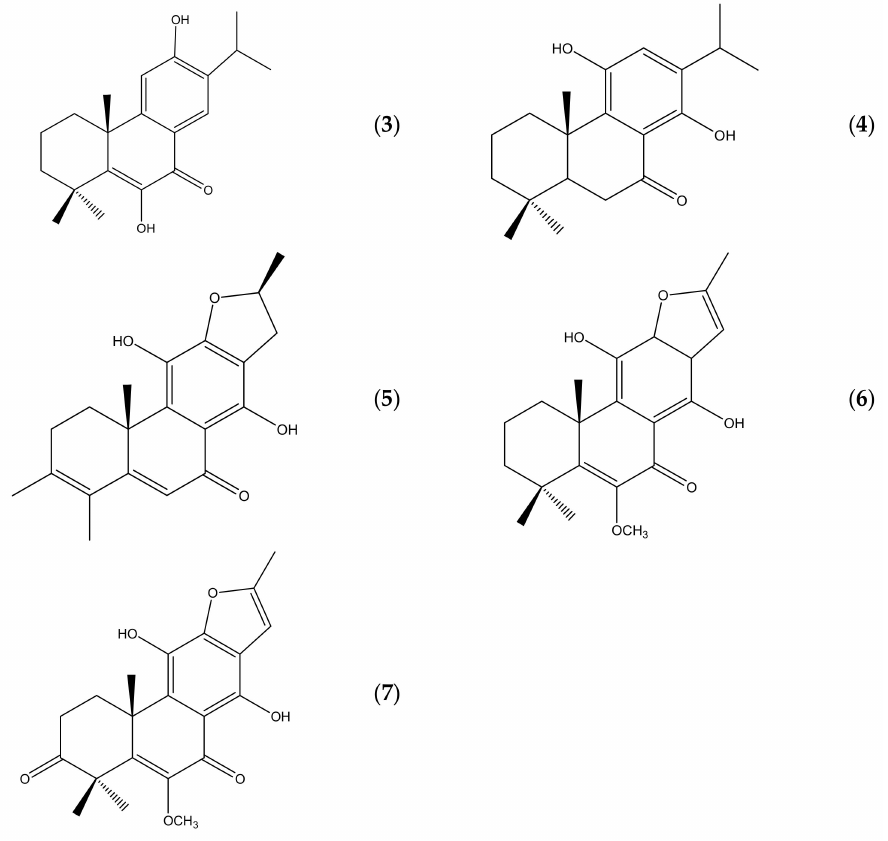
Figure 1. Chemical structures of compounds ( 1 )–( 7